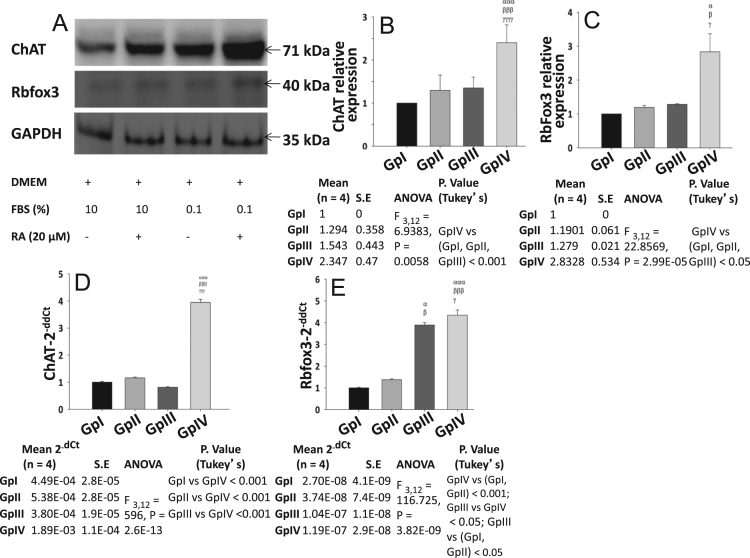
Protein and mRNA expression data for the neuronal marker of differentiation using various serum concentrations in the presence/absence of retinoic acid. A; Represents western blot of ChAT, Rbfox3, GAPDH. B, C; Relative quantification of ChAT and Rbfox3 w.r.t. GAPDH as the reference control. D, E; Real-time PCR data for ChAT and Rbfox3, analyzed by the 2-ddCt method using SDHA as the reference gene. Values are mean ± S.E. P ≤ 0.05 (α, β, γ), P ≤ 0.01 (αα, ββ, γγ), P ≤ 0.001 (ααα, βββ, γγγ) were considered to be statistically significant. α, Compared to GpI; β, Compared to GpII; γ, Compared to GpIII. Additionally, mean values, S.E., ANOVA, and Tukey׳s multiple comparisons statistics are shown in tabular form below their respective graphs.